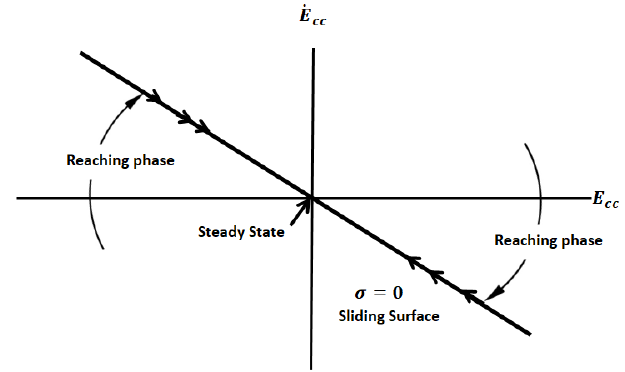
Figure 1. Sliding surface and sliding